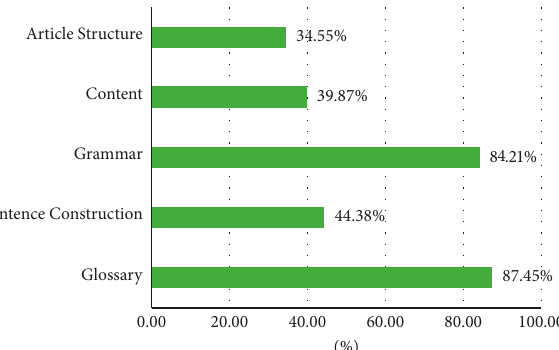
Figure 1: Survey about the problems in students’ English